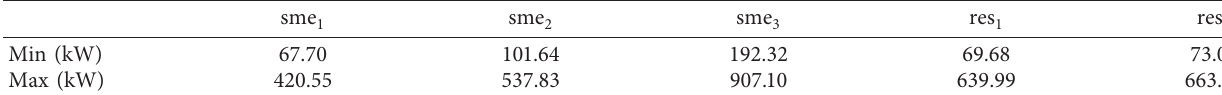
Table 1: Range of active power P of the aggregate loads.